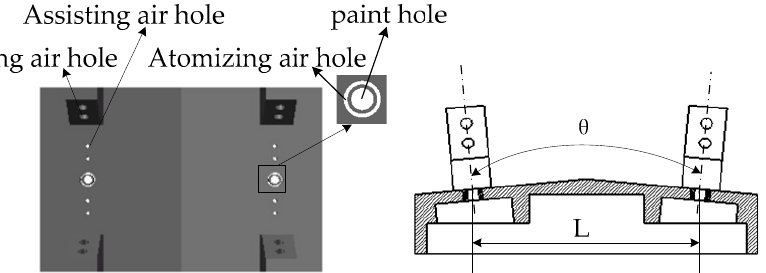
Figure 1. Geometry of the air cap of the double-nozzle air spray gun.